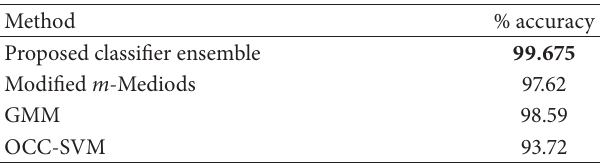
Table 3: Classification accuracies of proposed classifier ensemble as compared to individual classifiers using DiaretDB